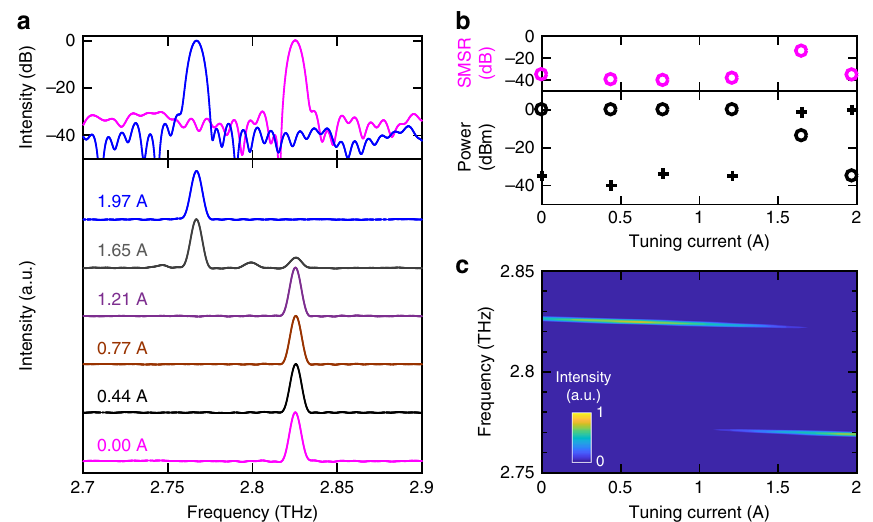
Fig. 1 Intensity measurements from the coupled-cavity laser. a Steady-state emission spectra obtained experimentally using a Fourier transform infrared spectrometer with bolometric detection, at a heat sink temperature of 5 K. The laser cavity was driven at peak output power with quasi-direct current pulses with amplitude 0.75 A. The current supplied to the tuning cavity was varied, but kept below threshold, and acts as a localised heating element. Inset: Single mode emission with a side mode suppression ratio (SMSR) of ~35 dB is obtained at two discrete emission frequencies for tuning currents 0 A (magenta) and 1.97 A (blue). b Top: Experimental variation of the SMSR as a function of tuning current. Bottom: The corresponding output power of the two modes at 2.825THz (circle) and 2.765THz (cross). c Simulation of the steady-state emission spectrum of the coupled-cavity laser for